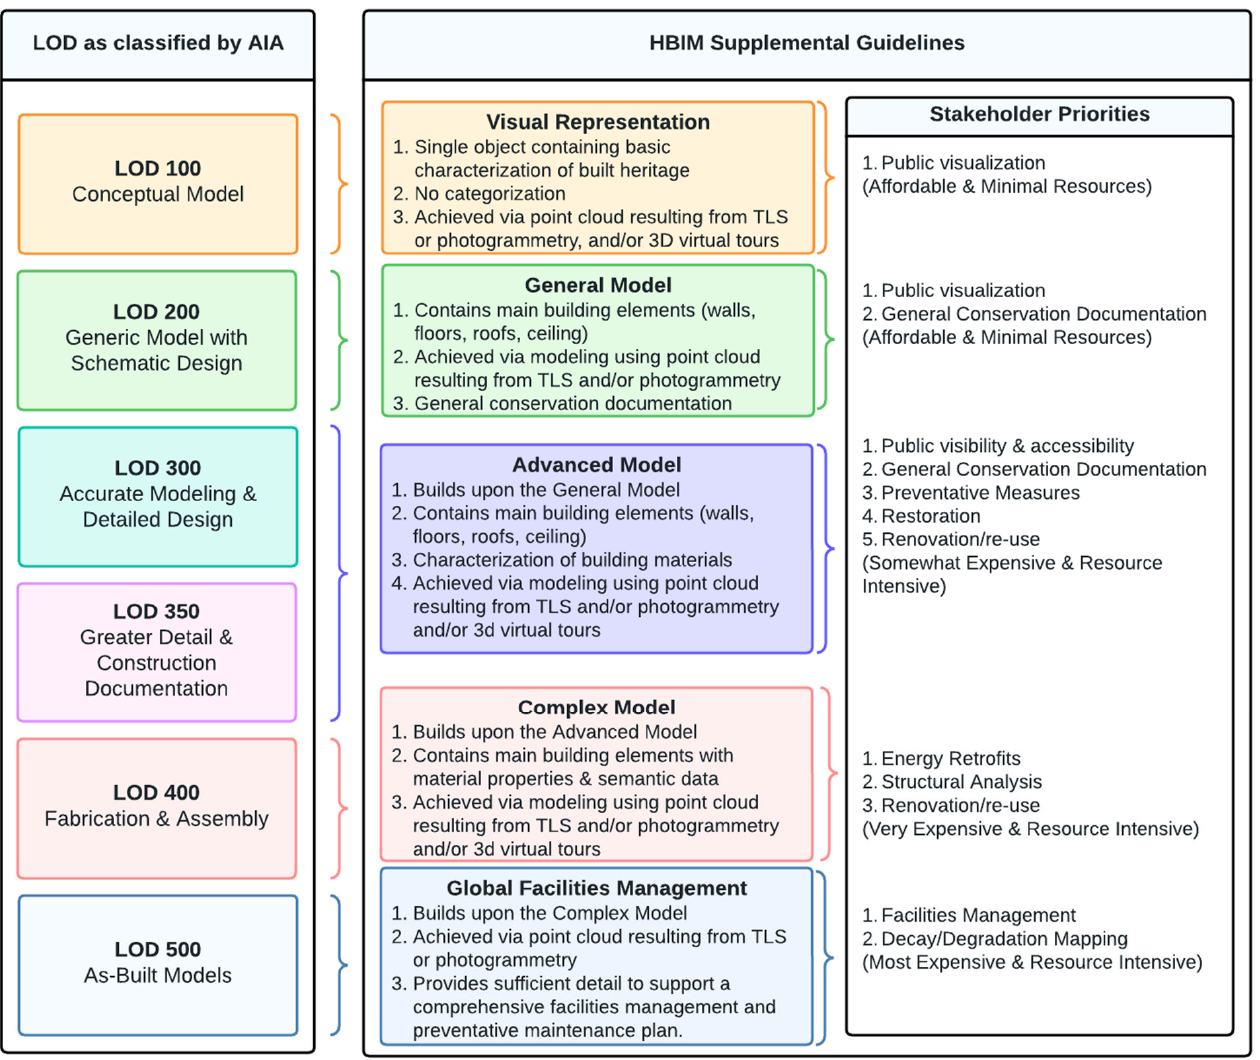
Figure 20. Proposed HBIM supplement for LOD Guidelines.